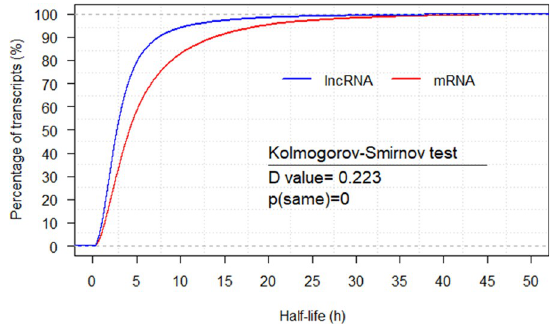
Fig 2. Half-life cumulative distributions for both lncRNAs and mRNAs